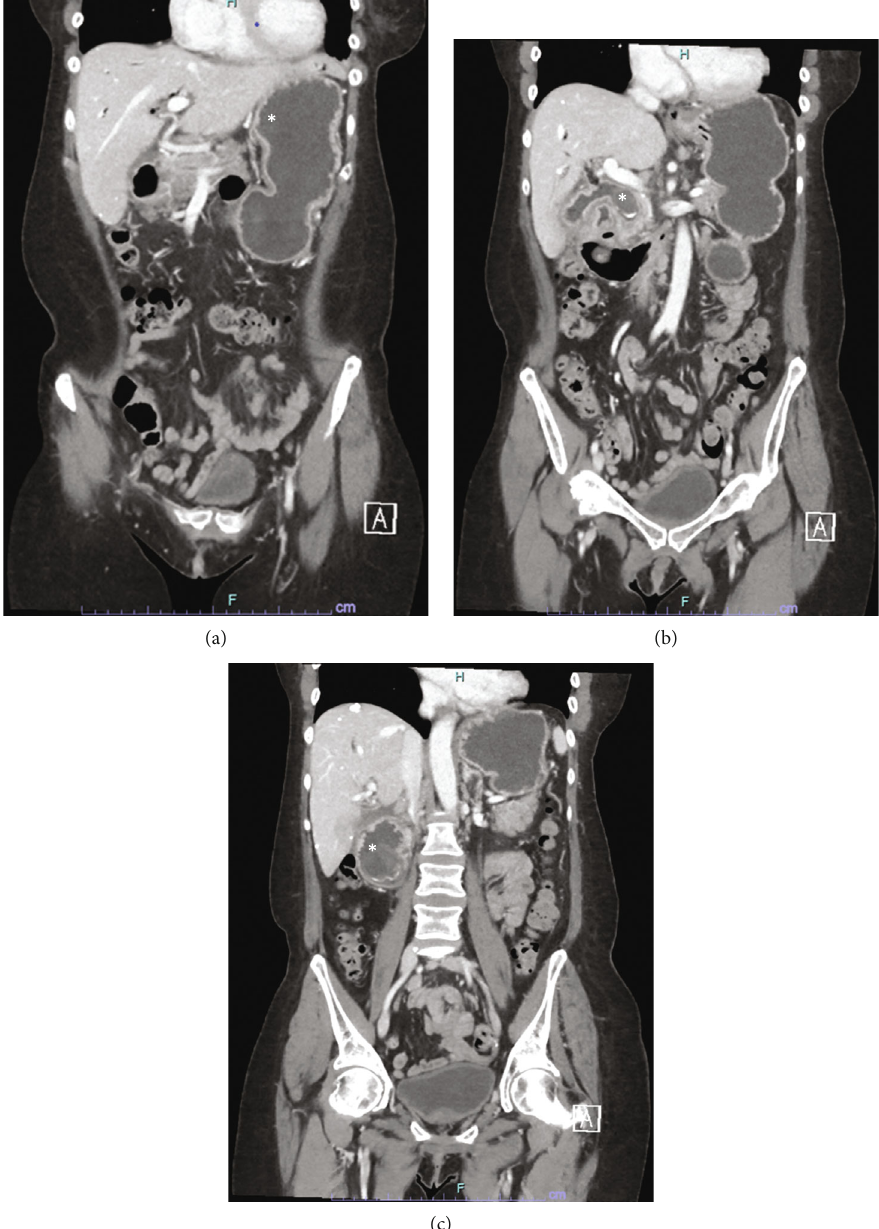
Figure 1: (a) CT A/P from OSH. The asterisk marks the dilated stomach from gastric outlet obstruction. (b) CT A/P from OSH. The asterisk marks the location of a 2.5cm gallstone in the CBD. (c) CT A/P from OSH. The asterisk marks the location of a 3.5cm gallstone in the 2 nd portion of